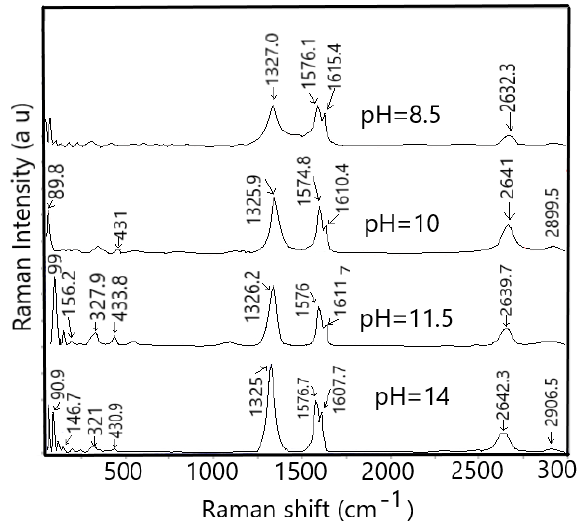
Figure 9: Raman spectra of ZnO-1.4 wt% Graphene hybrids after thermal treatment in nitrogen at 450 ∘ C, for different pH values of the suspension during sonochemical